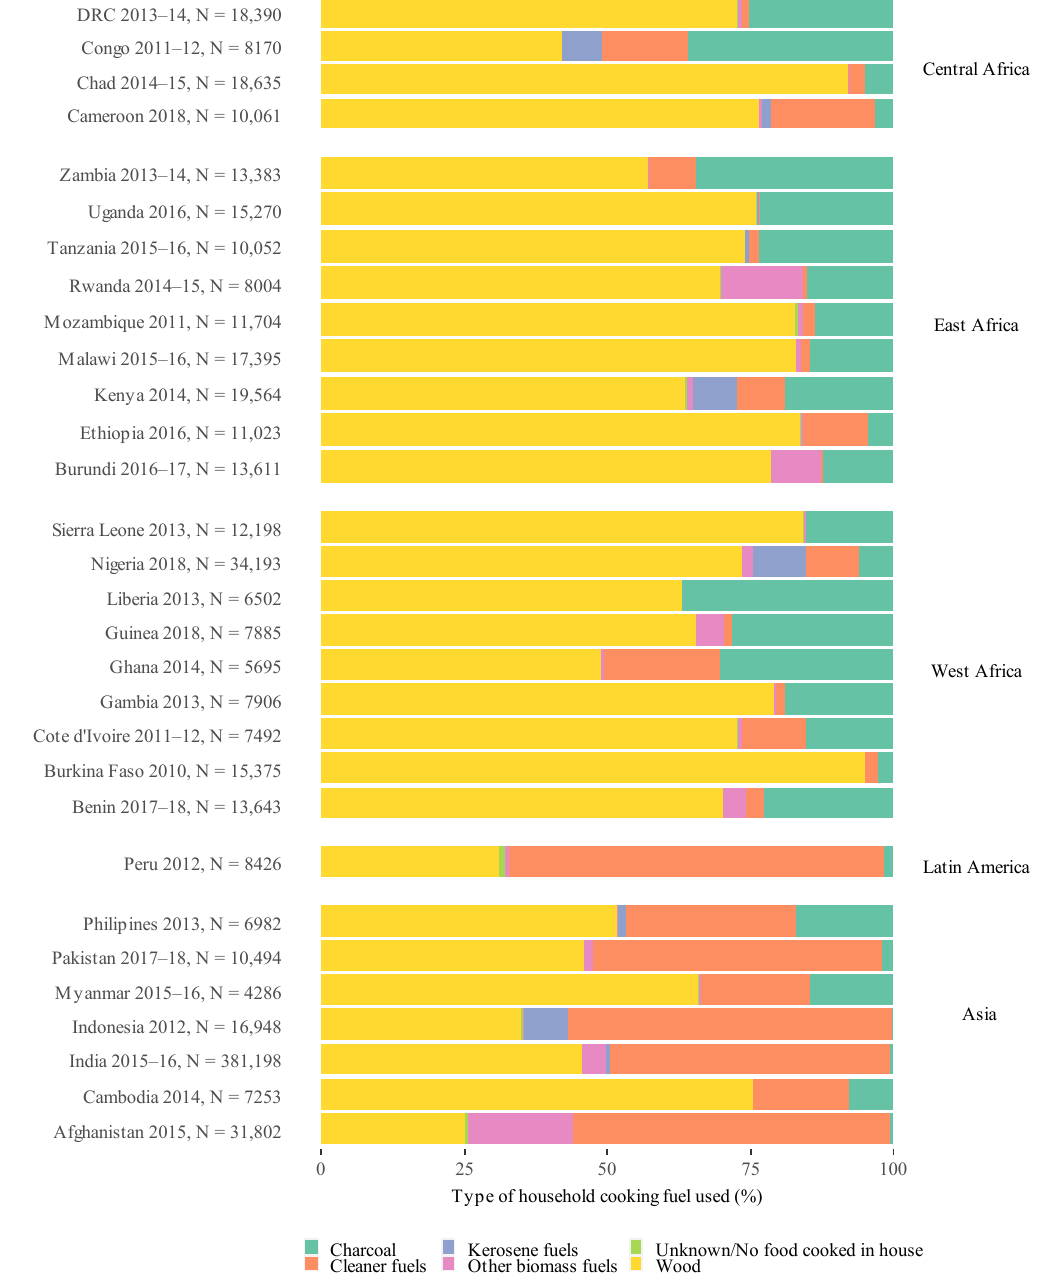
Figure 1. Proportion of clean, kerosene, wood, charcoal, other biomass (dung, crop residue) fuel use within each country, ordered by geographical region.